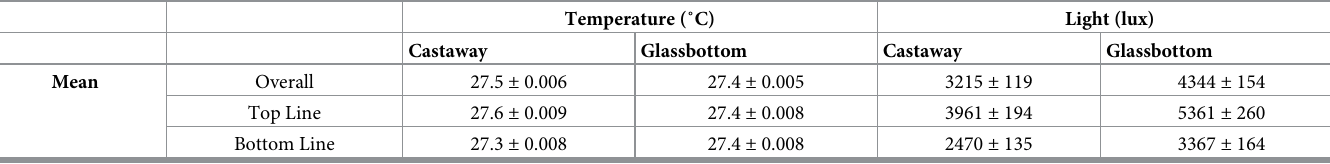
Table 2. Summary of environmental parameters ( ± SE) monitored at two coral line nurseries in The